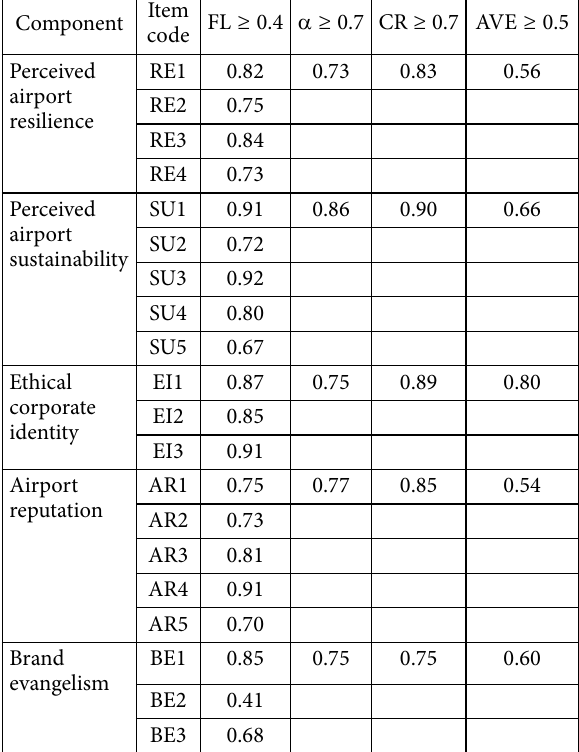
Figure 1. Proposed conceptual model Table 3. Measures for checking reliability and validity Table 4. Discriminant validity: AVE values versus